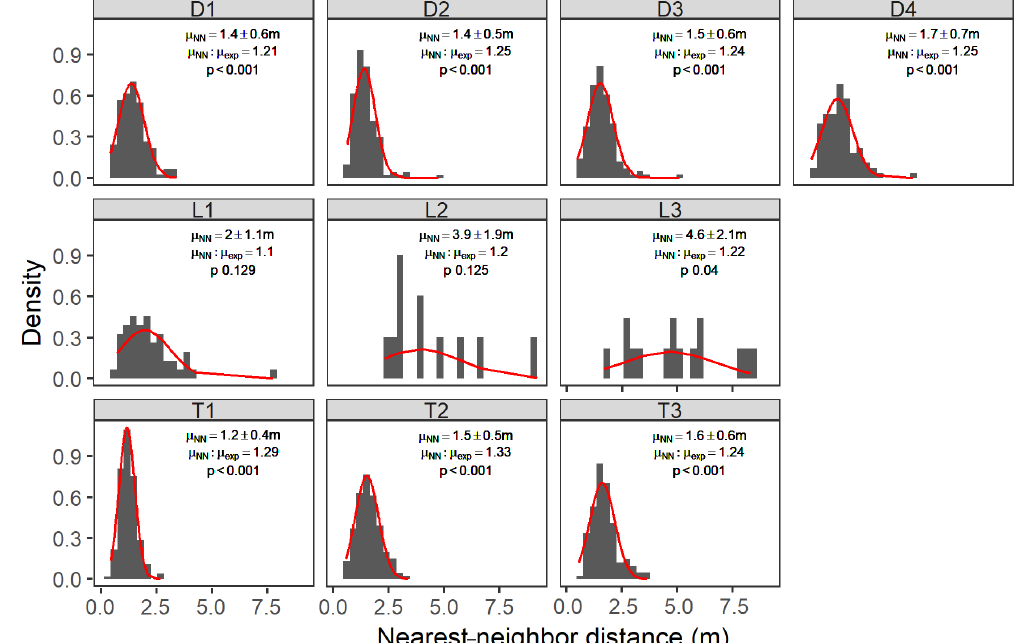
Figure 8. Hummock nearest-neighbor distance distributions across sites. Bars are scaled density histograms overlaid with best-fit normal distributions (red lines). The text indicates the mean nearest-neighbor distance ( µ NN ± SE – standard error); the ratio of the measured mean nearest-neighbor distance and the expected nearest-neighbor distance for complete spatial randomness ( µ exp ); and the p value for a z score comparison between µ NN and µ exp . p values less than 0.001 indicate that hummocks are significantly